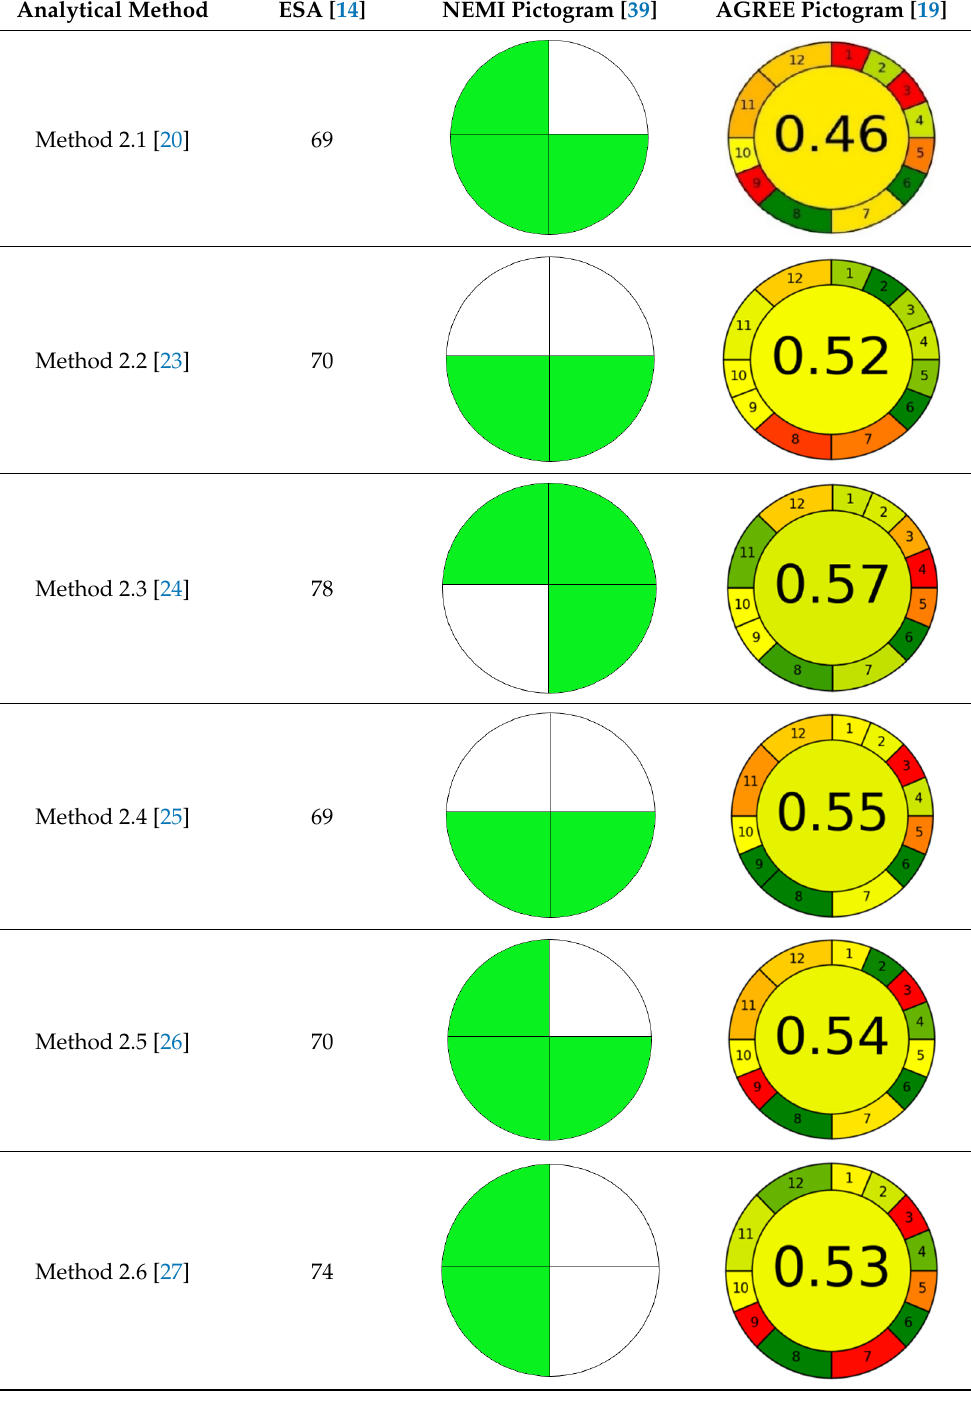
Table 2. Greenness assessment results of methamphetamine and cannabis/cannabinoid analytical procedures.